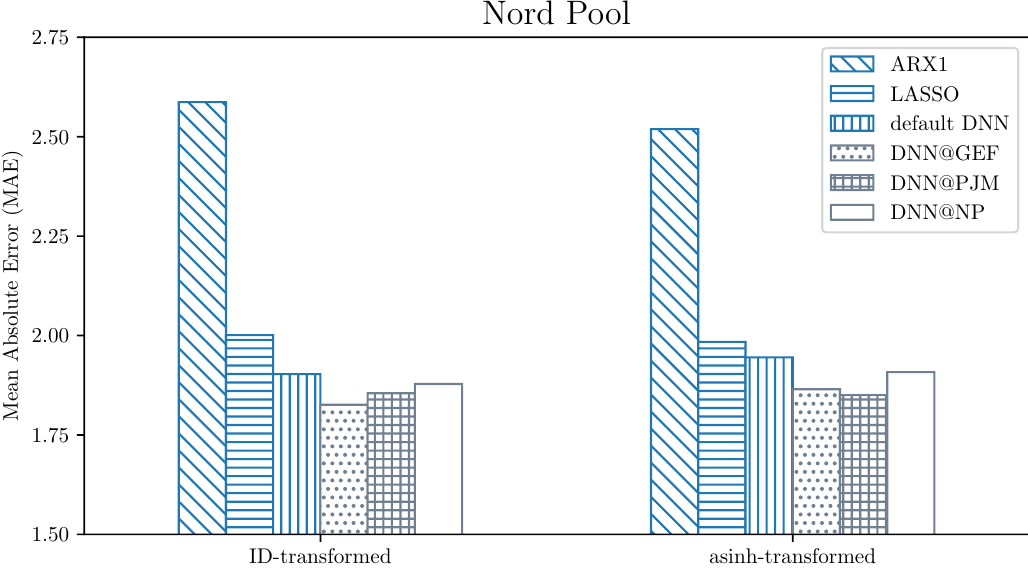
asinh-transformed1 . ID-transformed Figure 4. Visualization of the MAE errors for Nord Pool data across the benchmark (darker shade) and fine-tuned (lighter shade) ensembles, separately for ID (left part) and asinh-transformed data (right part). Each bar represents the ensemble of all forecasts made using a given model (represented by a filling pattern). The @DATA notation refers to the precalibration dataset used for hyper-parameter